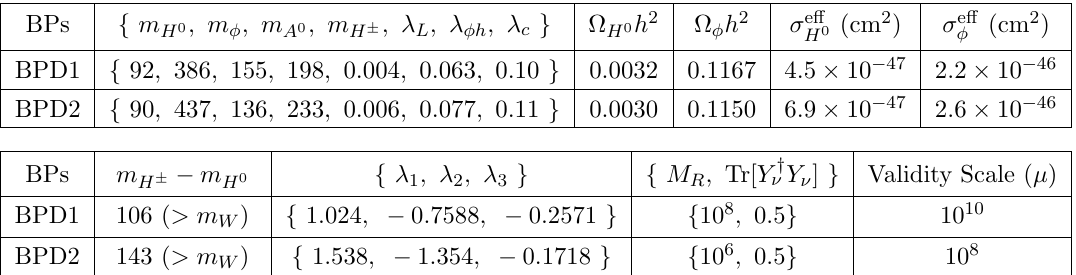
table 5 correspond to (cid:1) M = m (cid:0) m > m , where the charged scalar H (cid:6) decay H (cid:6) W (cid:6) H 0 through on-shell W (cid:6) . Each table (table 4 and table 5) consists of two parts: the (cid:12)rst part contains all the relevant dark sector masses, couplings, relic density and direct search cross-sections of both DM components. The second part demonstrates the mass di(cid:11)erence ((cid:1) M = m (cid:0) m ), choice of right handed neutrino mass, neutrino Yukawa and the H (cid:6) H 0 maximum scale of validity ( (cid:22) ) of the Higgs vacuum.